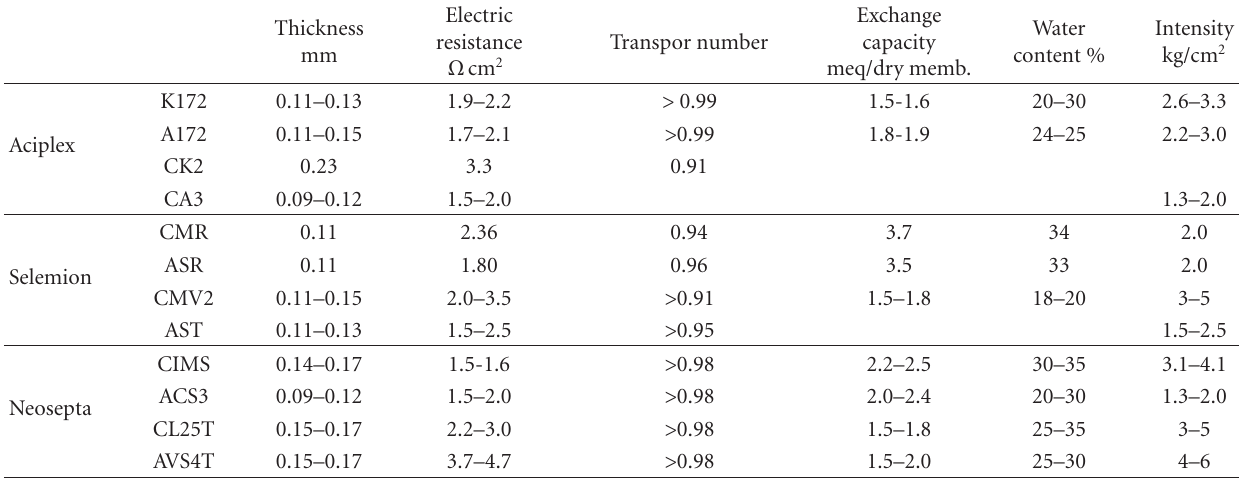
Table 1: Specifications of ion-exchange